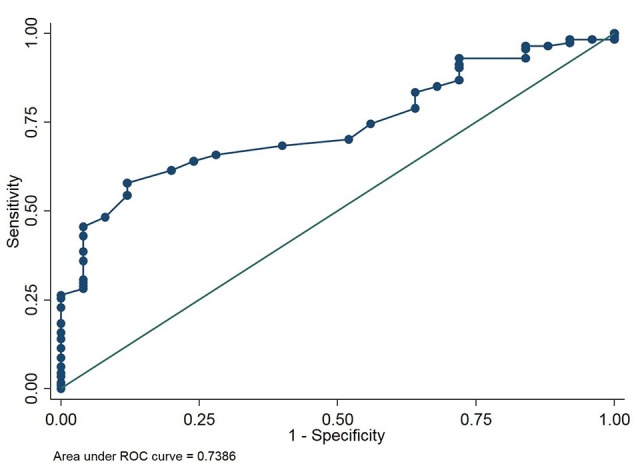
Receiver operating characteristic curve testing the ability of the CT derived pulmonary artery/ascending aorta ratio to detect PH defined as a mean pulmonary artery pressure ≥ 25 mmHg.